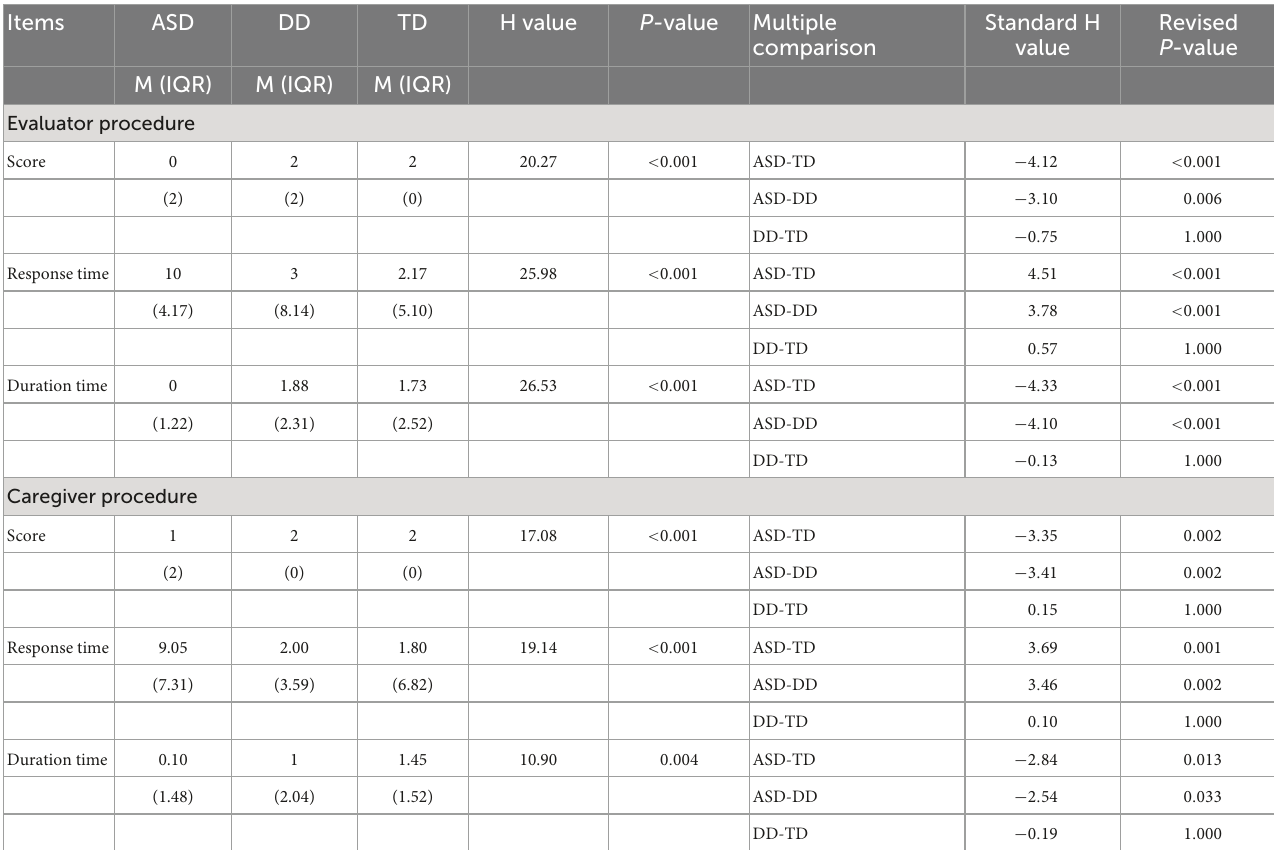
TABLE 2 Computer-rated results of RTN among toddlers with ASD, DD, and